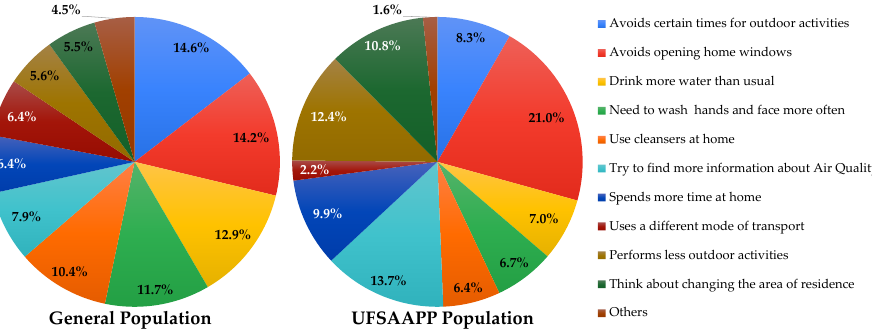
Figure 11. Changes made in the daily life when citizens felt affected by air pollution, for the general population (left) and the UFSAAPP population (right). For the general population, the main changes were to avoid certain time periods for outdoor activities (14.6%), to avoid opening home windows (14.2%), and to drink more water than usual (12.9%). For the UFSAAPP population, the main changes were to avoid opening the home windows (21.0%), to try to find more information about air quality (13.7%) and to perform less outdoor activities (12.4%). It is relevant to highlight that 10.8% of the respondents from the UFSAAPP population revealed considering changing their